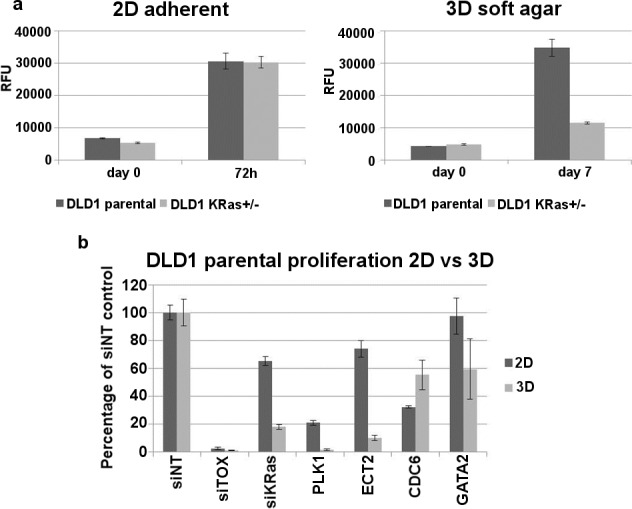
ECT2 targeting siRNAs inhibit the growth of DLD1 parental cells in 2D and 3D culture conditions.(a) DLD1 parental and KRAS+/- cells were cultured for 72h (2D) or 7 days (3D) before proliferation was quantified using Alamar Blue (10% v/v). DLD1 KRAS+/- cells in which the KRASG13D allele had been knocked out proliferated poorly on soft agar. Bars represent the mean and standard error of 3 technical replicates. (b) DLD1 parental cells were screened in 2D (72h) and 3D (7d) following transfection with siRNAs and proliferation was assessed using Alamar Blue (10%v/v). Bars, expressed as a percentage of the proliferation detected in cells transfected with the non-targeting control siRNA, represent the mean and standard error of 6 technical replicates.